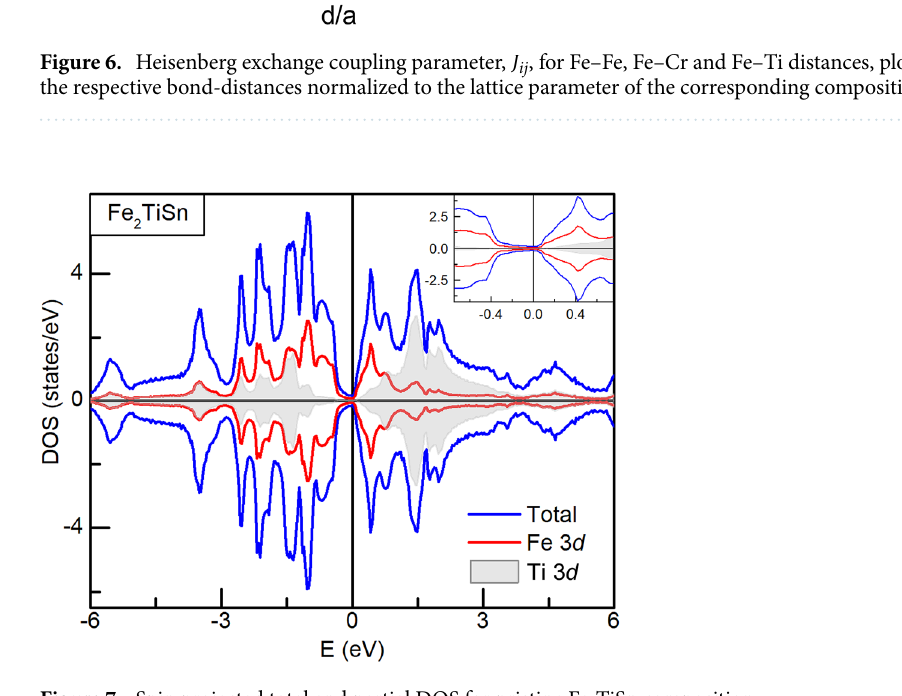
Figure 7. Spin projected total and partial DOS for pristine Fe 2 TiSn